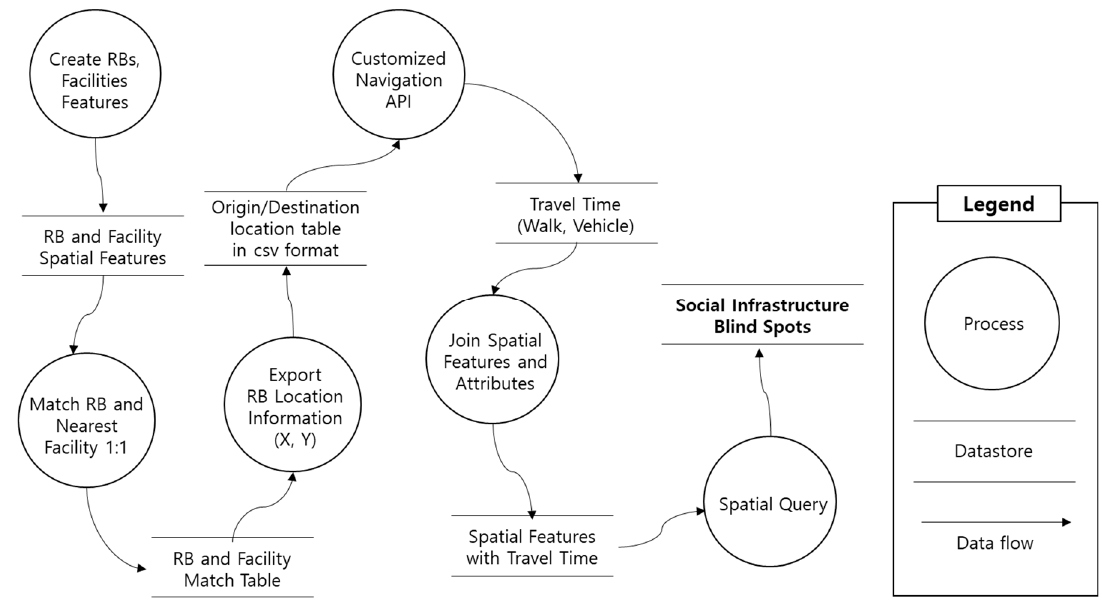
Figure 4. Data flow diagram to find social infrastructure blind spots.